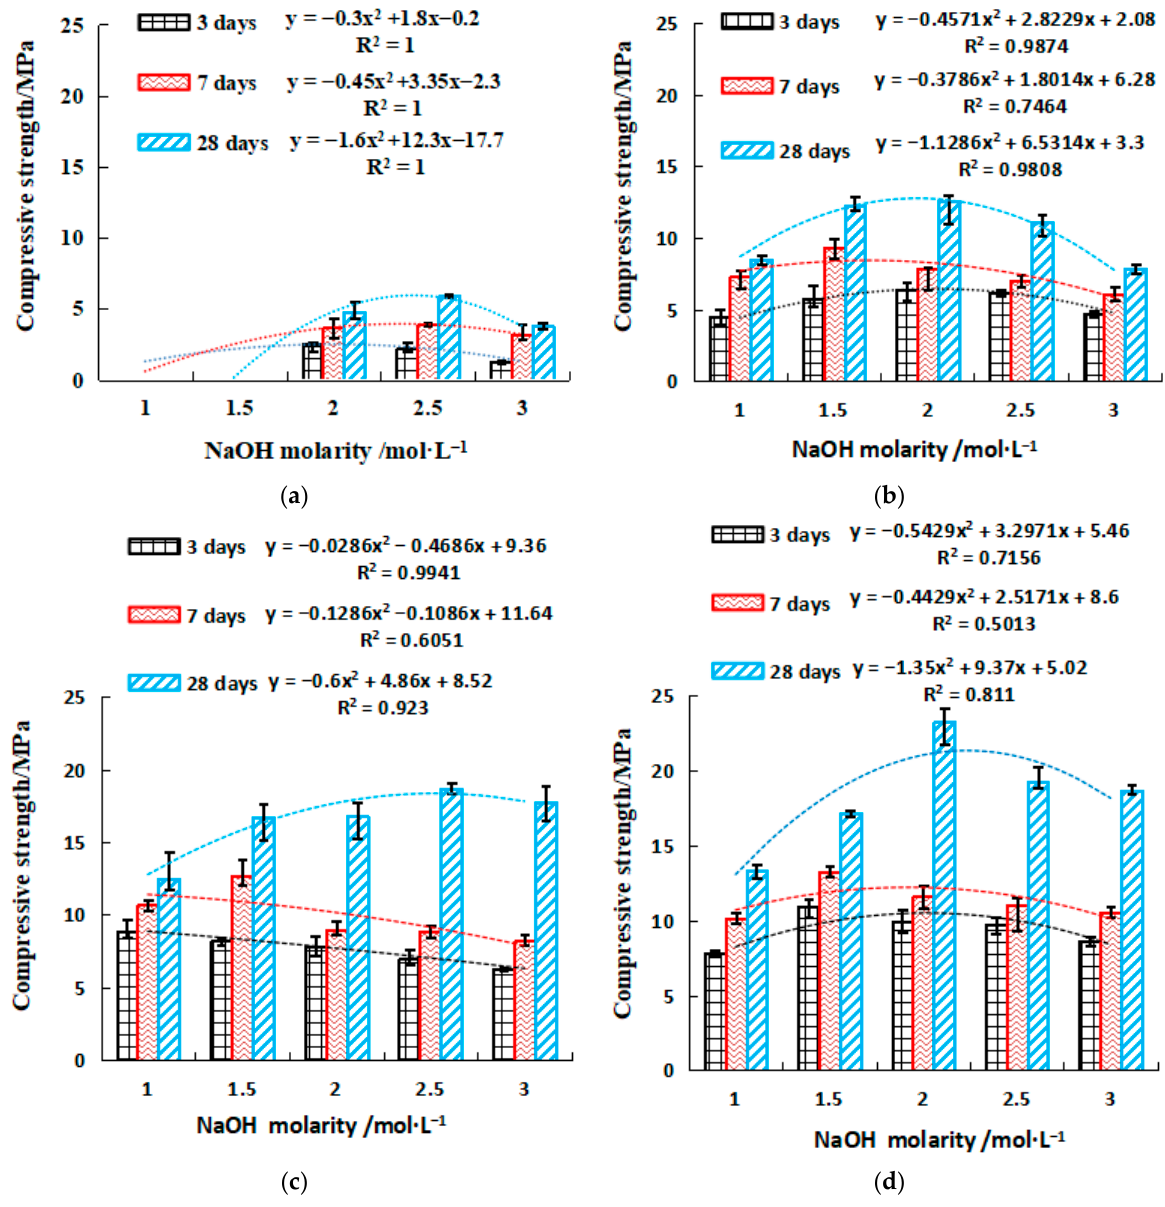
Figure 4. Compressive strength of NaOH single activator. ( a ) 10% GGBFS, ( b ) 20% GGBFS, ( c ) 30% GGBFS, ( d ) 40% GGBFS.